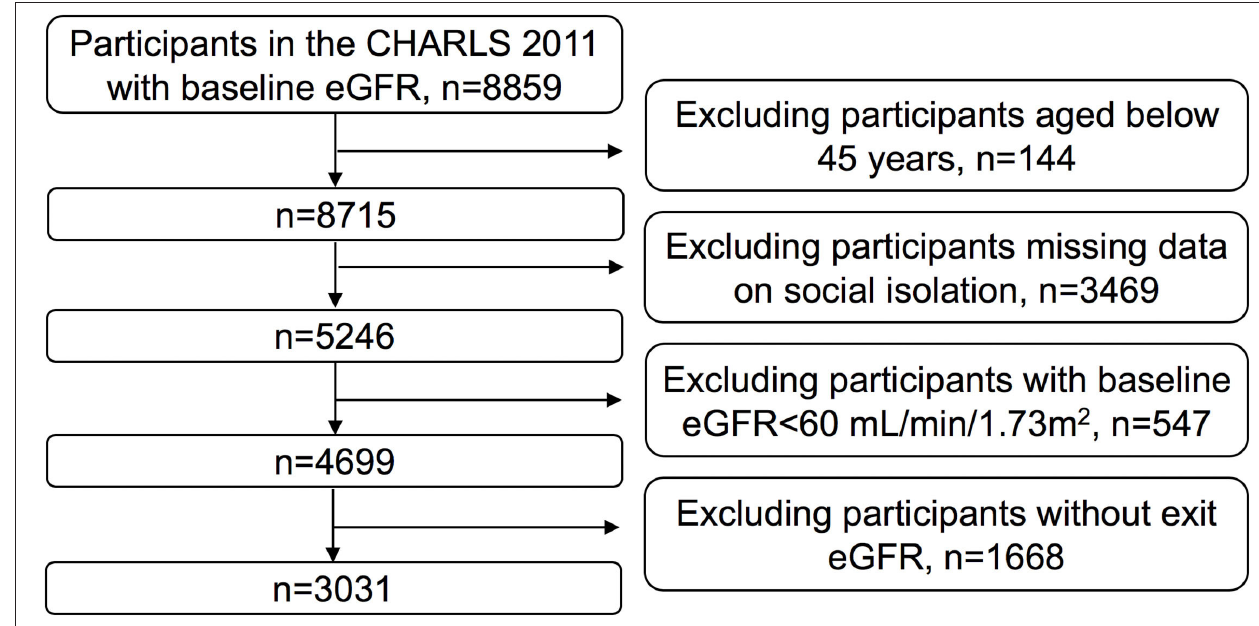
FIGURE 1 | Flow diagram of participants for the